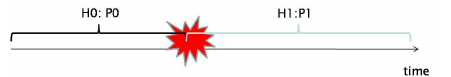
Figure 5. Illustration of quickest